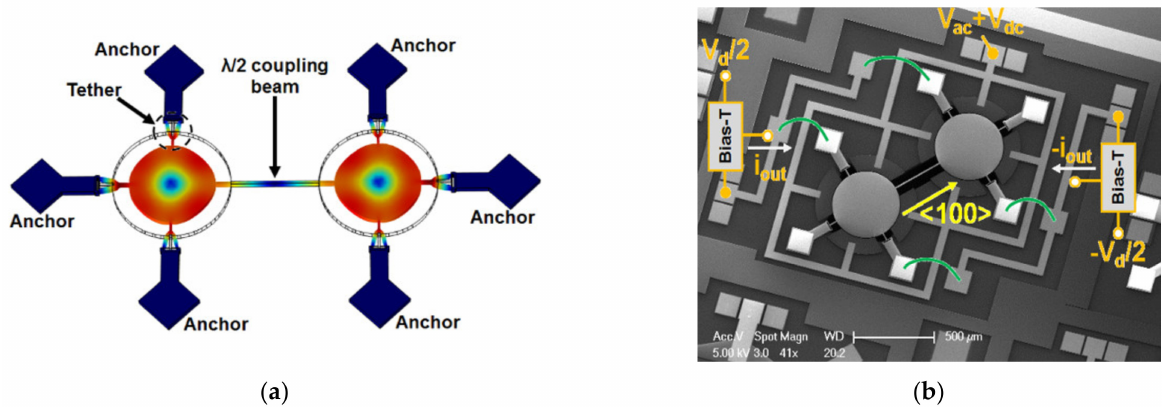
Figure 20. ( a ) FEM simulation of 2-DoF BAW disk resonators with in-phase extensional mode shown; ( b ) SEM image of the fabricated 2-DoF BAW disk resonators with capacitive actuation and piezoresistive sensing. Reprinted with permission from Ref.